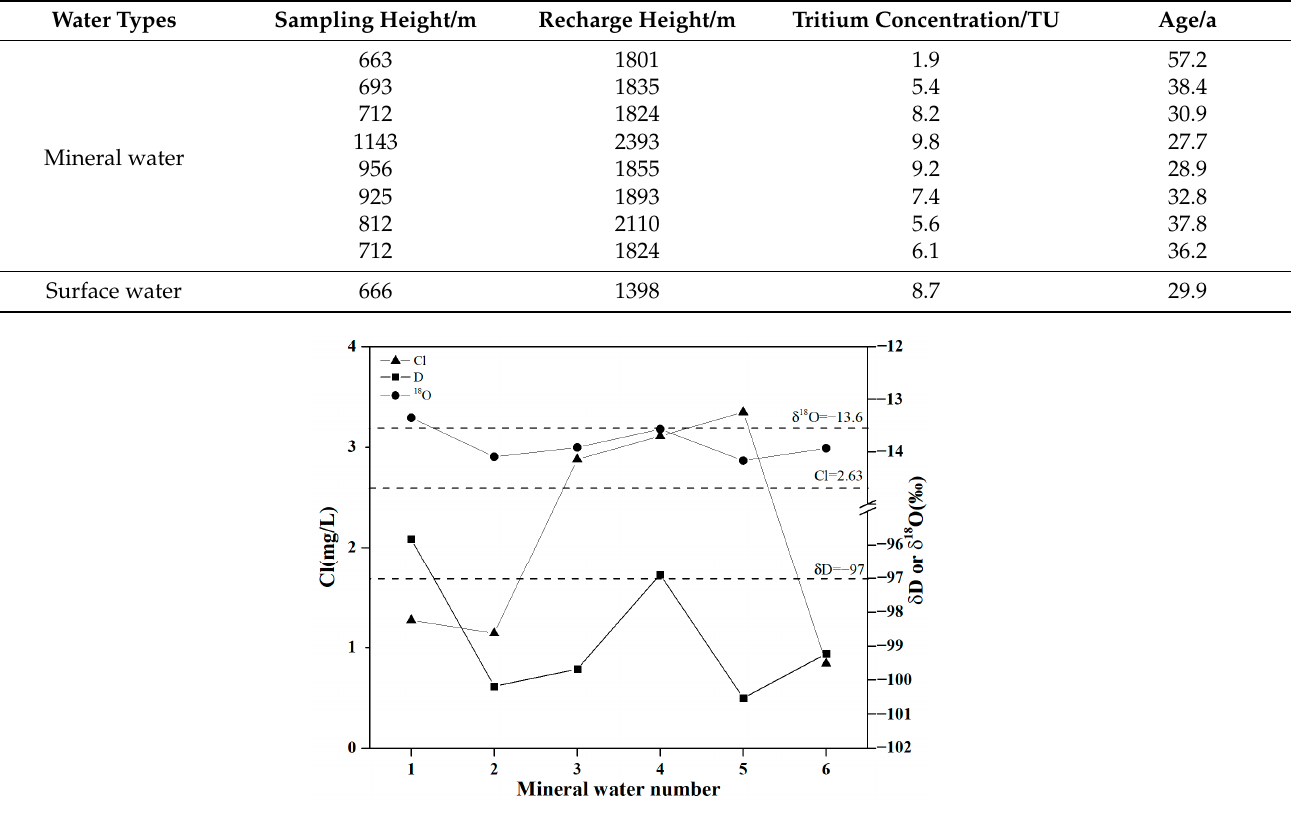
Figure 8. δ D, δ 18 O and Cl − content of mineral and surface water (the dash lines present content of surface water).